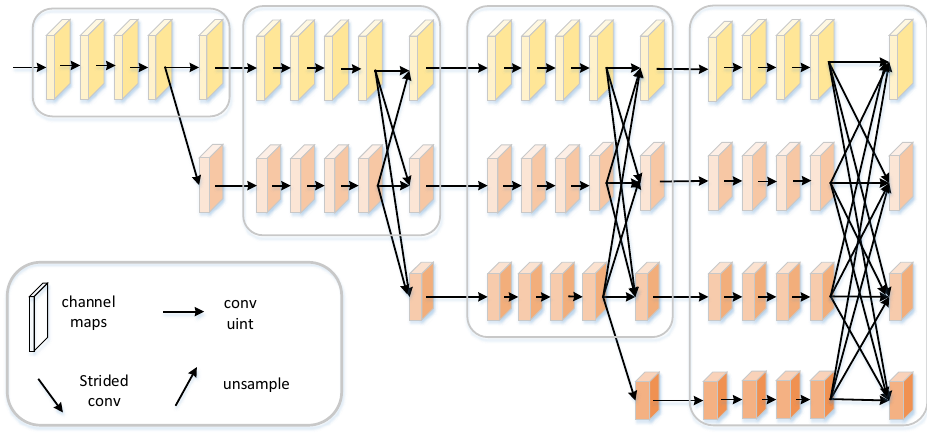
Figure 2. The architecture of High-Resolution Network. There are four stages. The first stage consists o high-resolution convolutions. The second, third and fourth stages repeat two-resolution, three- resolution and four-resolution blocks, respectively. HRNet can connect high-to-low convolution streams in parallel and maintain high-resolution features through the whole process